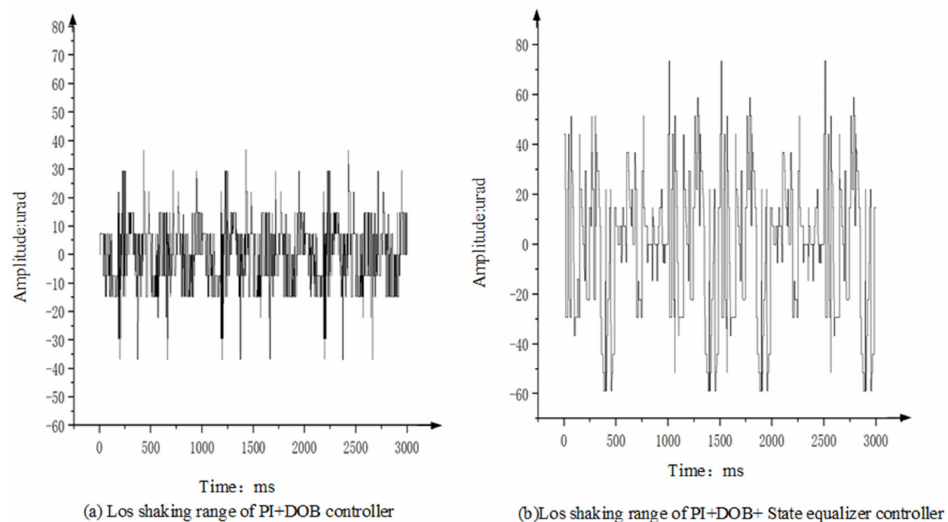
Figure 20. Shaking range of the controller’s